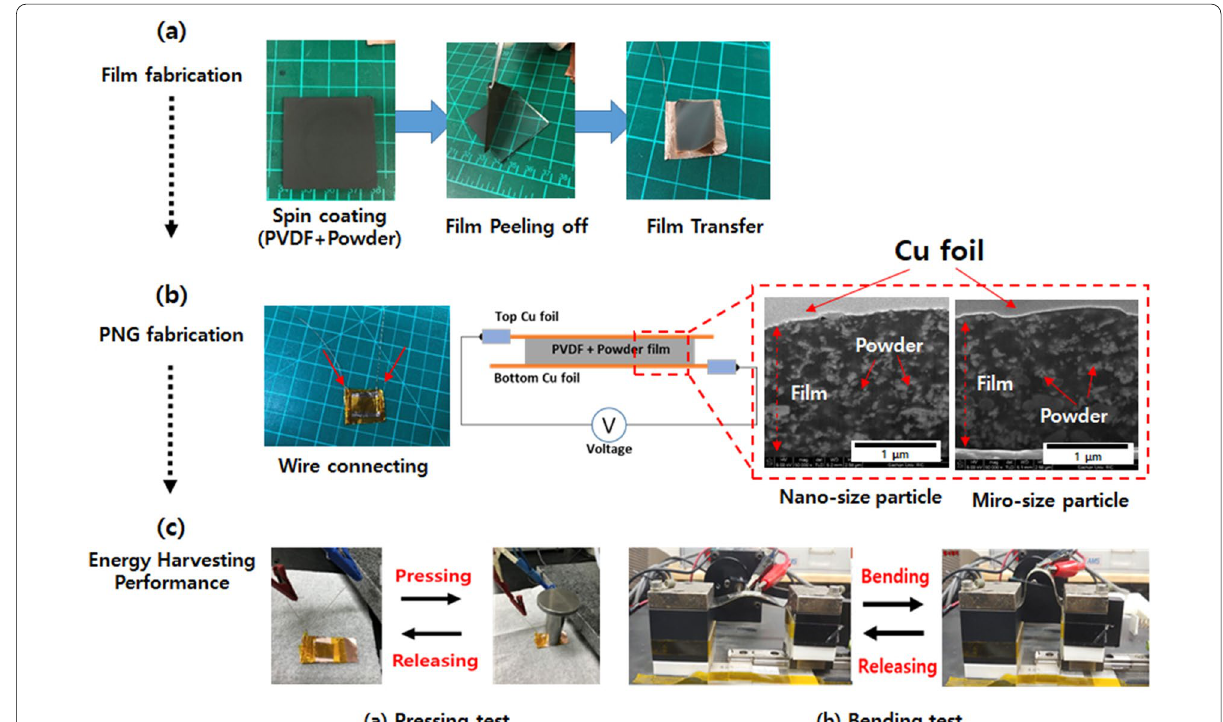
Fig. 1 Fabrication process of PNG contained PVDF and BLT